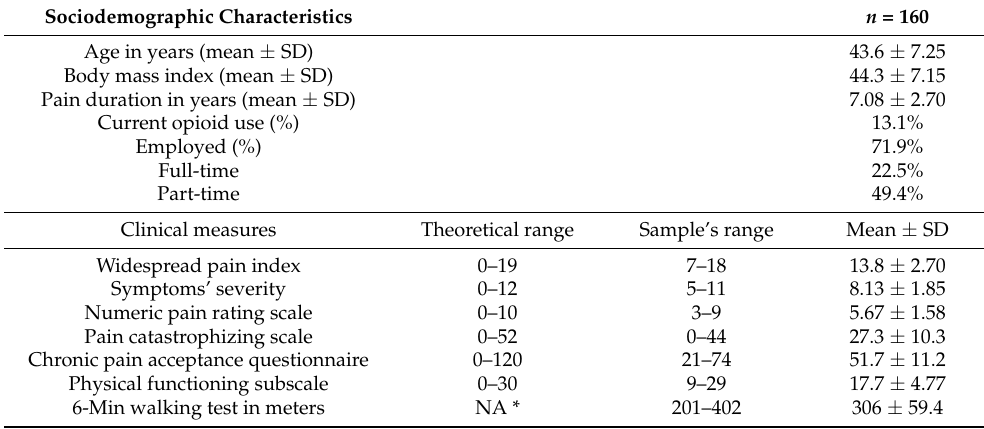
Table 1. Means and standard deviations of sociodemographic characteristics and clinical measures. The theoretical range and actual range are reported. n = 160.